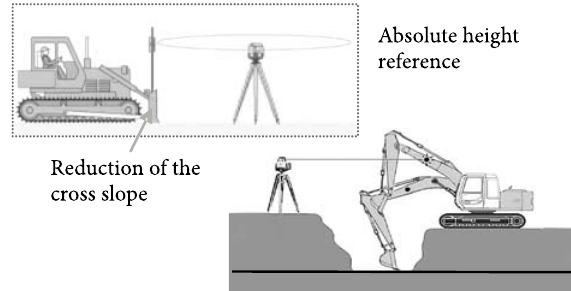
Fig. 2. Rotation ring laser for dozer / Basic excavator system (Stempfhuber 2006)